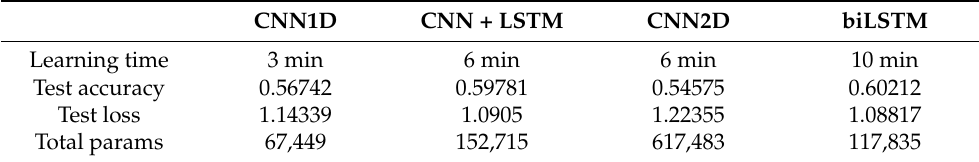
Table 9. Resulting training parameters.